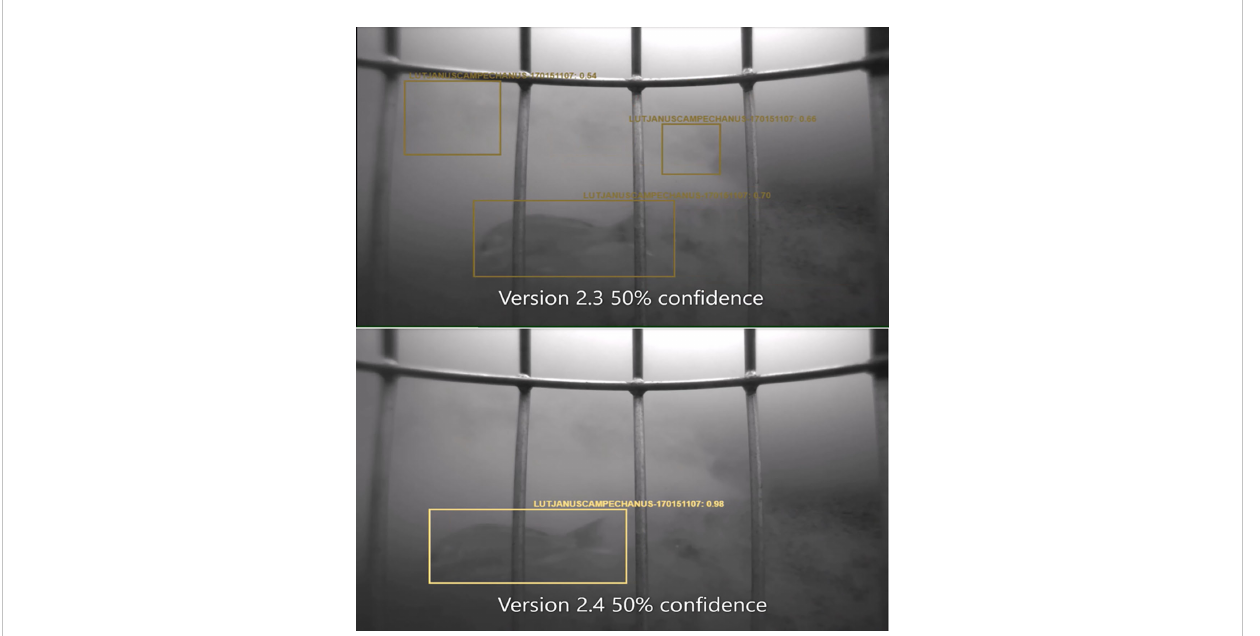
FIGURE 9 Example of reduction of false-positives and increase in con fi dence of detection and identi fi cation (Station 762101220 as turbidity plume clears the fi eld of view). “ 50% con fi dence ” in fi gure refers to the con fi dence threshold of the